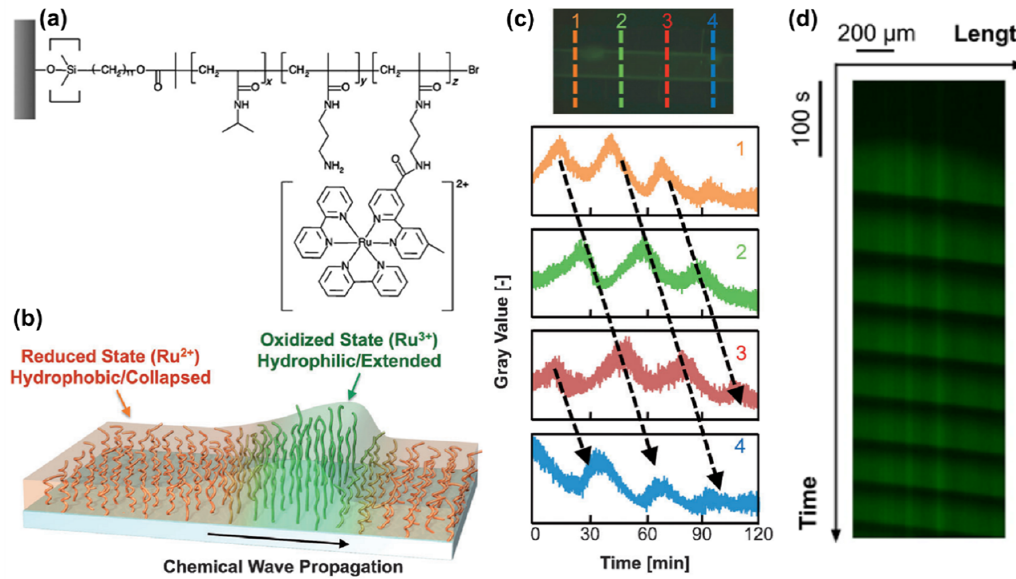
Figure 6. ( a ) Structure of the grafted-from self-oscillating polymer brushes (SOPB). ( b ) Schematic representation of the propagation of a chemical wave in the SOPB. ( c ) Top: fluorescence microscopy images of a glass capillary modified with the SOPB; bottom: oscillating profile of fluorescence intensity for each SOPB position. Adapted and reproduced with permission from [85], Wiley, 2013. ( d ) Spatiotemporal pattern of chemical wave propagation in a SOPB (adapted and reproduced with permission from [86], American Chemical Society, 2015). In both ( c , d ) the Belousov–Zhabotinsky (BZ) reaction conditions were: [HNO 3 ] 0.81 M, [NaBrO 3 ] = 0.15 M, [malonic acid] 0.1 M.